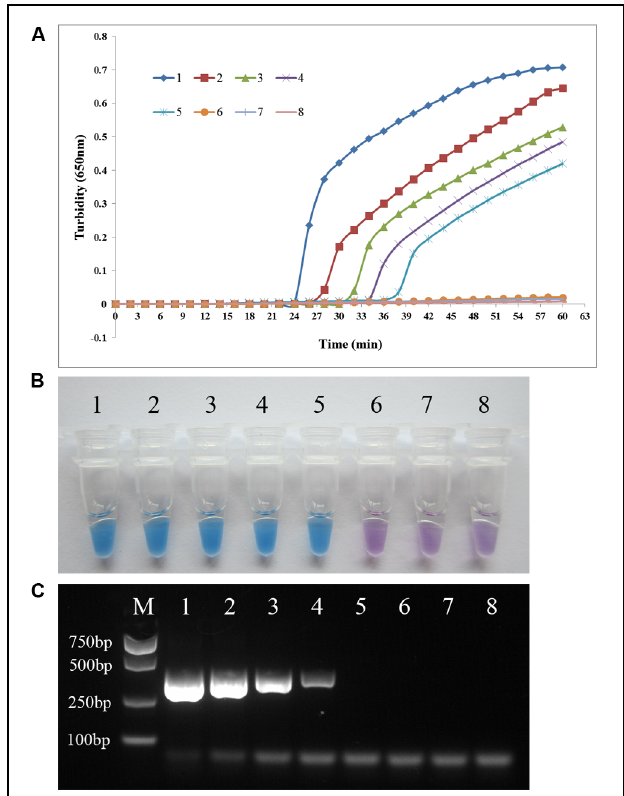
FIGURE 4 | PSR assay sensitivity. Comparative sensitivities of the PSR assay (A) and (B) and traditional PCR (C) for detection of the P. aeruginosa toxA gene. 1–7: 10-fold serial dilution of genomic DNA extracted from P. aeruginosa ATCC 15442 (23.0 ng/ μ l to 0.023 pg/ μ l); 8: negative control (double-distilled water). The expected PCR product size was 396